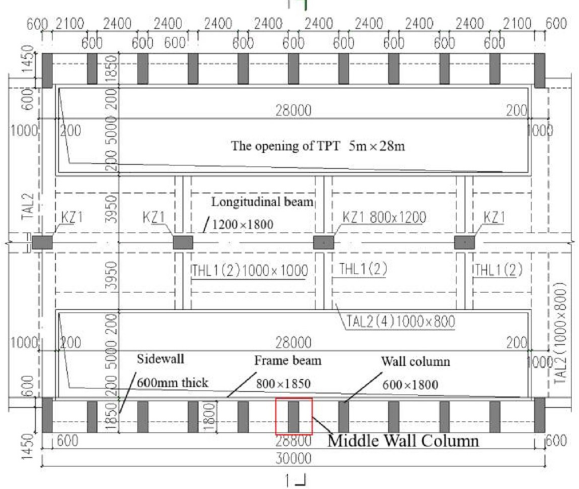
Figure 10. Plan of the metro station with a reserved large-size opening (unit: mm).